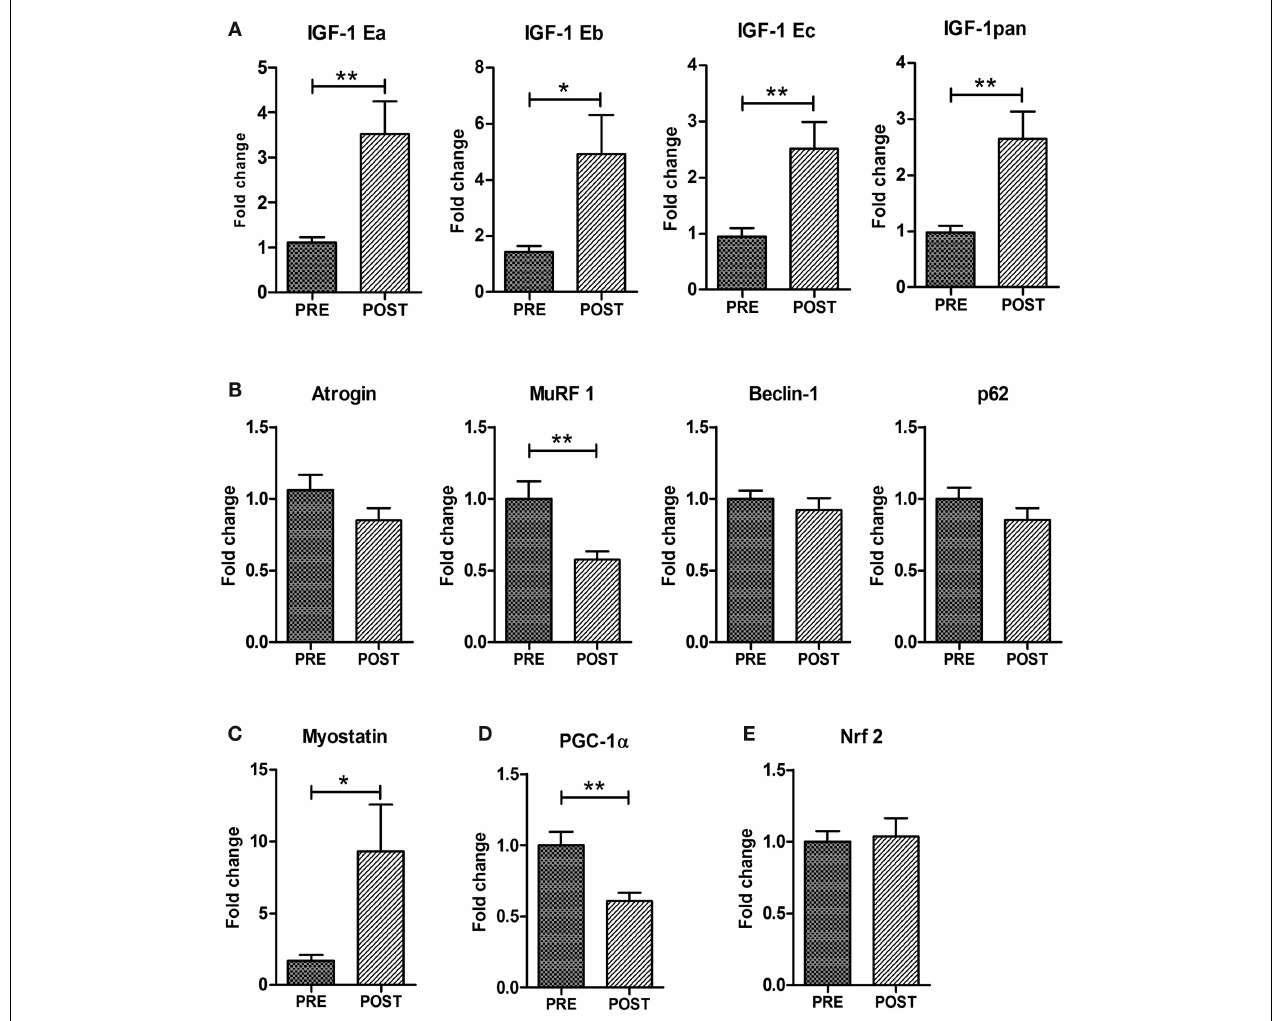
FIGURE 3 | Expression analyses of genes controlling muscle mass and metabolism . Real time PCR analysis for the expression of IGF-1 isoforms (total IGF-1pan, IGF-1Ea, IGF-1Eb, IGF-1Ec) (A) Atrogin-1, MurF-1, Beclin1, p62 (B) , Myostatin (C) , PGC1 α (D) , and Nrf2 (E) . Data are represented as average ± SEM.